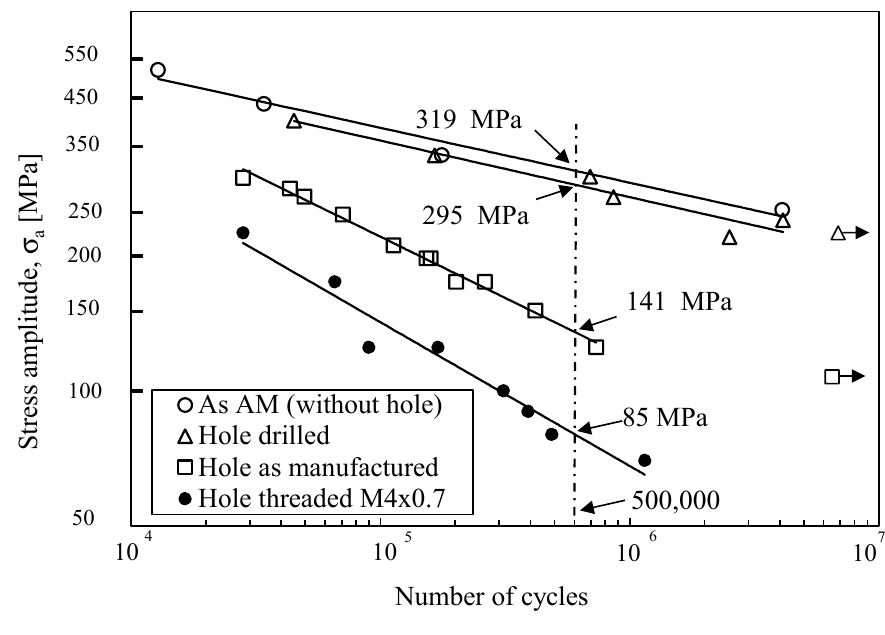
Figure 4. Comparison of S-N curves.